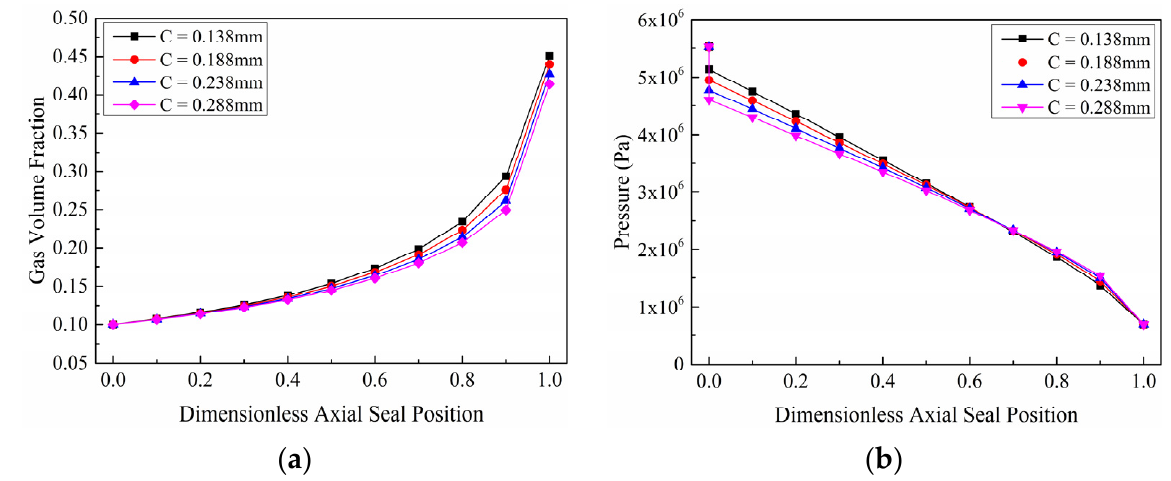
Figure 13. GVF and pressure distribution along the axial direction within the model seals with different clearances under the conditions of inlet GVF = 10% and ∆ P = 48.3 bars. ( a ) GVF distribution, ( b ) pressure distribution.